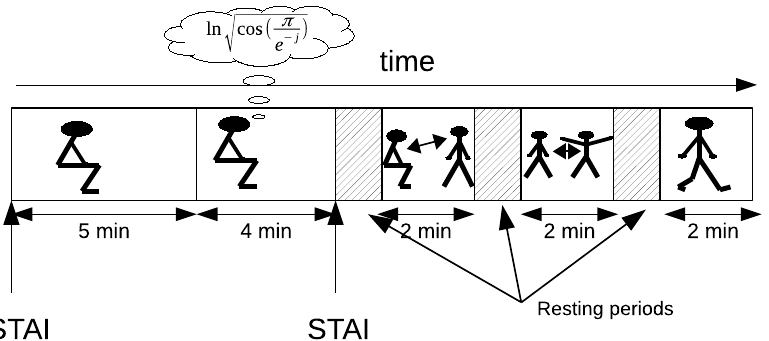
Figure 8. Experimental temporal sequence. It contains five activities: initial rest, arithmetic task, sit-to-stand activity, raising the arms, and walking. Two State-Trait Anxiety Inventory (STAI) tests were given to participants at the beginning and end of the arithmetic task. The remainders were three simple PAs with short interleaved resting periods to stabilize physiological variables.